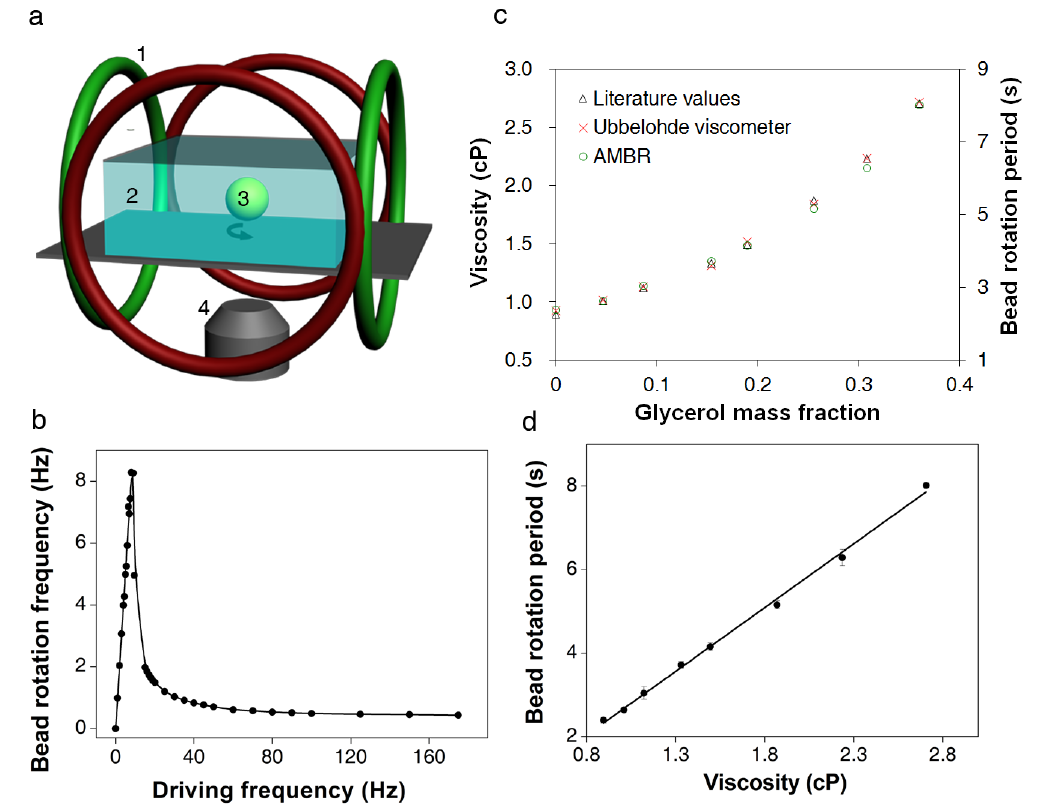
Figure 1. Asynchronous magnetic bead rotation (AMBR) microviscometer. ( a ) A